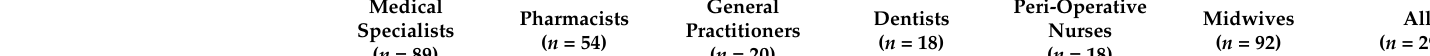
Table 3. Knowledge of health care providers (HCPs) on guidelines concerning breastfeeding women undergoing (surgical) procedures and sources to evaluate medication compatibility with breastfeeding. Data shown as number